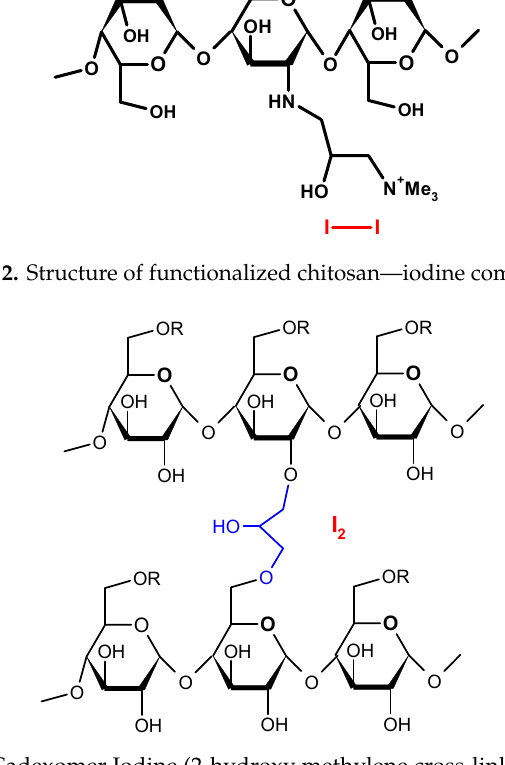
Figure 3. Structure of Cadexomer Iodine (2-hydroxy methylene cross-linked (1-4) α -D-glucan ether containing iodine) [19].